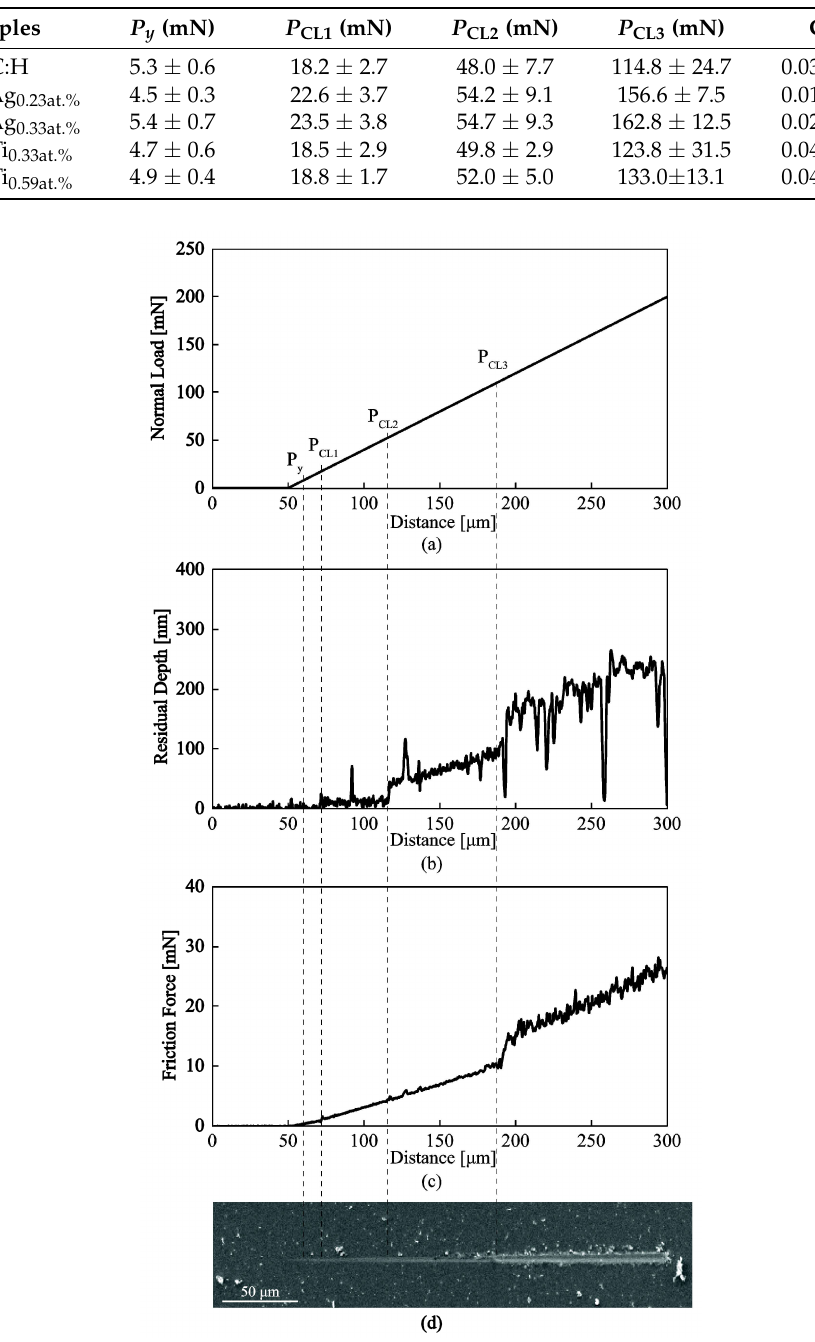
Table 4. Summary of tribomechanical metrics extracted from nanoscratch tests.